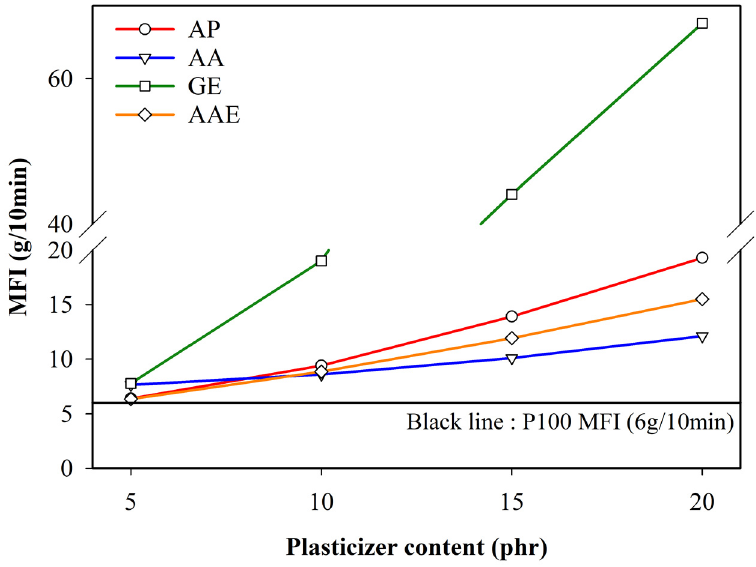
Figure 1. Variation of melt flow index (MFI) for neat PLA and PLA plasticized with varying plasticizer types and contents.